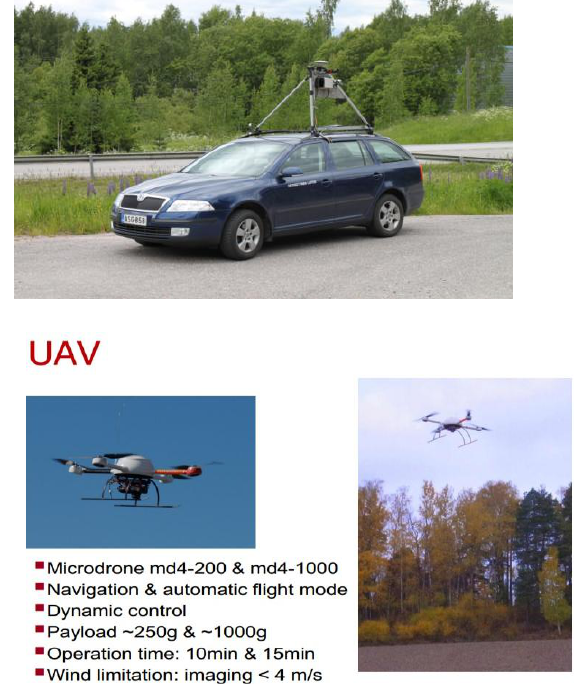
Figure 2. Sensors. UP: FGI Sensei mobile laser scanning system: consists of Ibeo Lux scanner, GPS, and INS, with a scanning speed of 38,000 Points/ second and with ranging accuracy of 10 cm as well as angular resolution of 0.25°. Right: FGI UAV imaging-based system (from T.